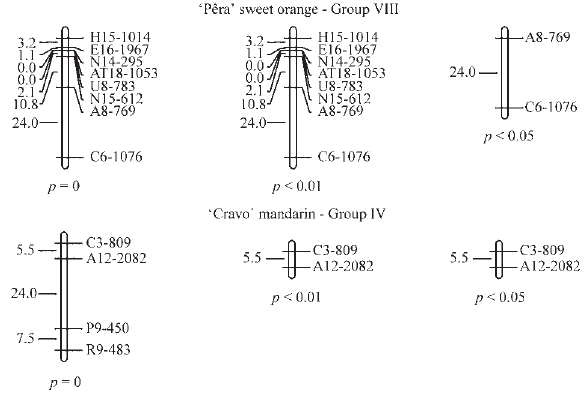
Figure 1 - Partial linkage map of Citrus showing the effect of excluding markerswithaskewedsegregationthatarepositionedattheextremitiesof the linkage groups of C. sinensis Osb. ‘Pêra’ and C. reticulata Blanco ‘Cravo’. The linkage groups were constructed using MAPMAKER with a pseudo-testcross strategy, a Kosambi function, LOD ≥ 6.0 and θ ≤ 0.40. p = 0, p < 0.05 and p < 0.01 refer to the probability of the expected Mende- lian segregation ratio (1:1) of the markers used to construct the